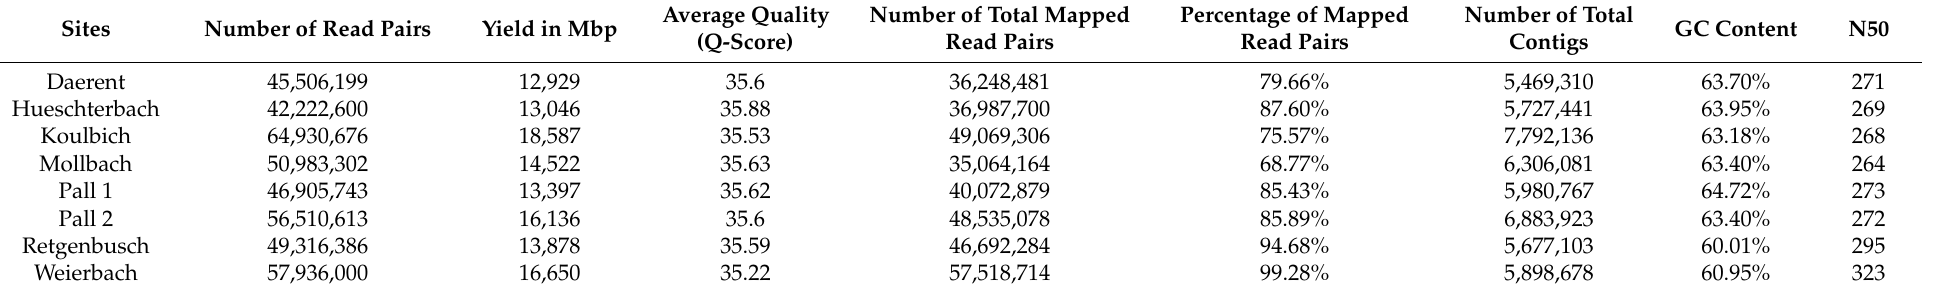
Table 3. Statistics of the metagenomic sequencing: raw data, assembly and mapping on the eight studied